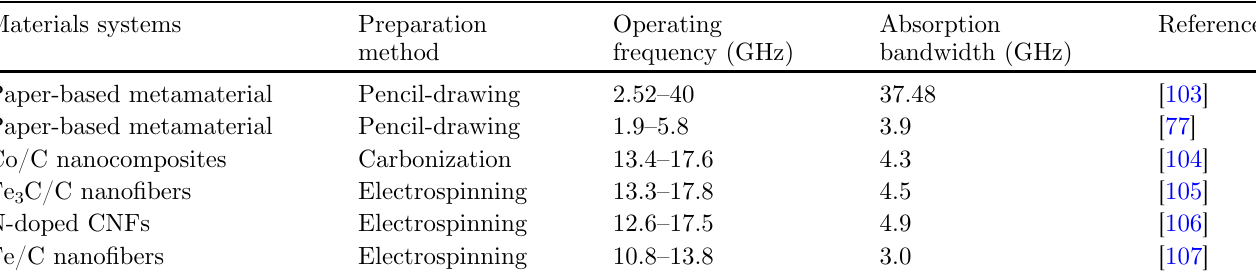
Table 2. Comparison of microwave absorption properties between paper-based metamaterials and conventional microwave absorption